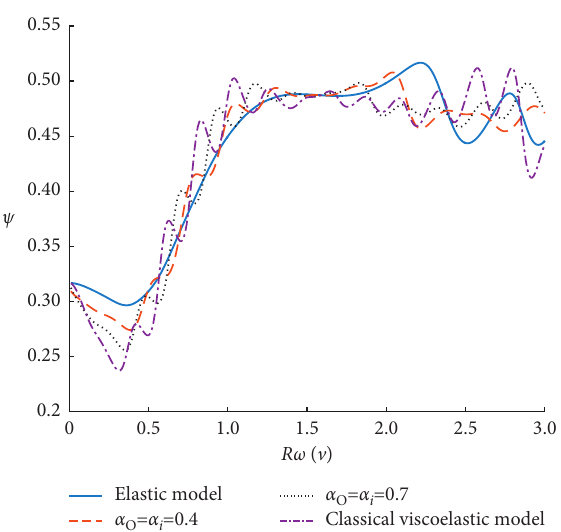
Figure 6: Curves of radial stress varying with frequency for dif- ferent order of fractional derivative.